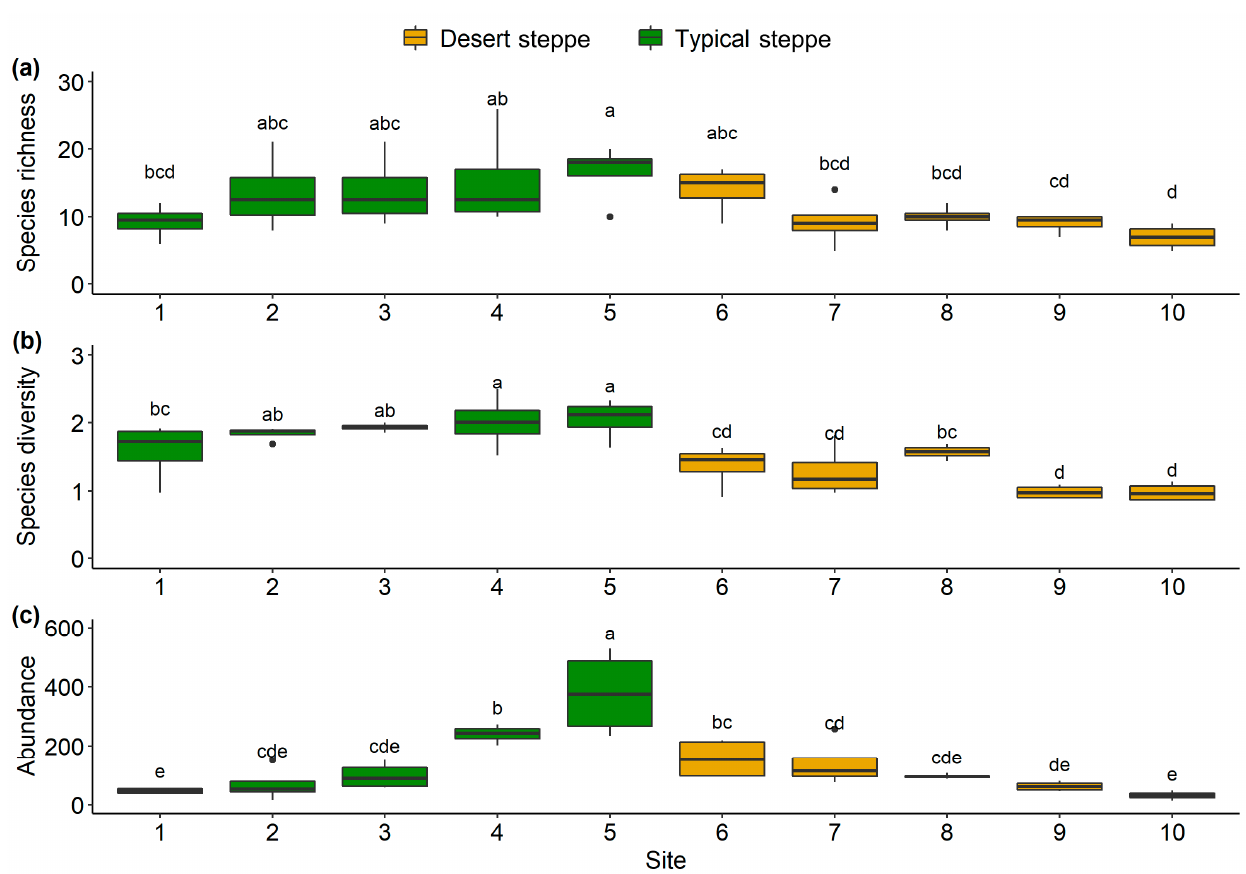
Figure 2. Species richness ( a ), Shannon diversity ( b ), and abundance ( c ) of ten sites along the latitudinal gradient. Diversity metrics were compared with Wilcoxon test based on the sampling nights of each site. Different letters show significant differences between sites.